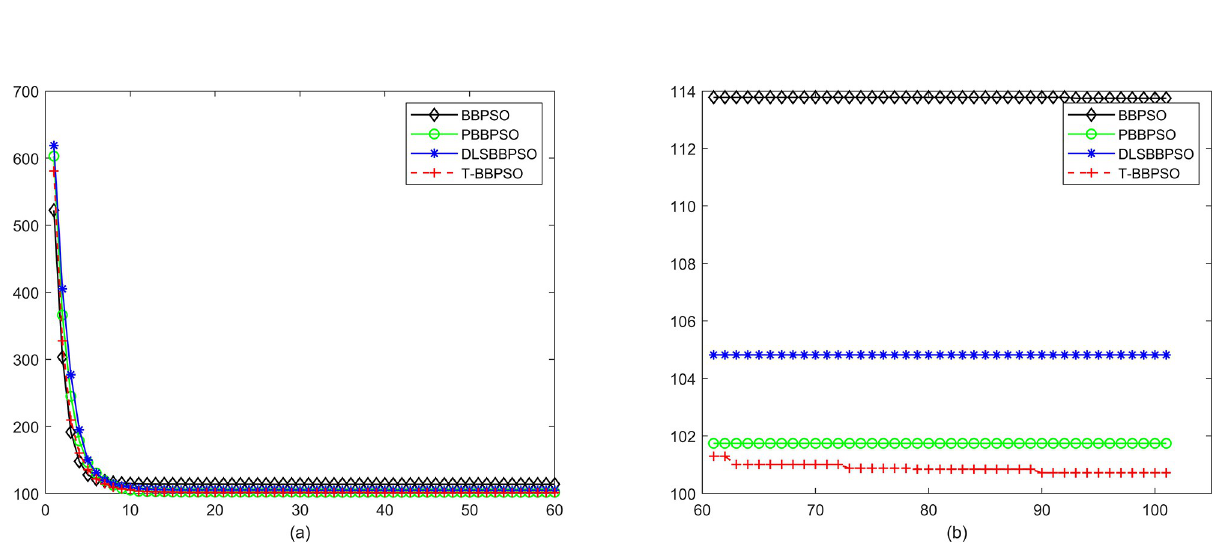
Fig 10. Comparison of convergence speed between BBPSO, PBBPSO, DLS-BBPSO and TBBPSO, f 8 , (a) iteration 0–6000, (b) iteration 6000–10000 the unit is 100 iteration.